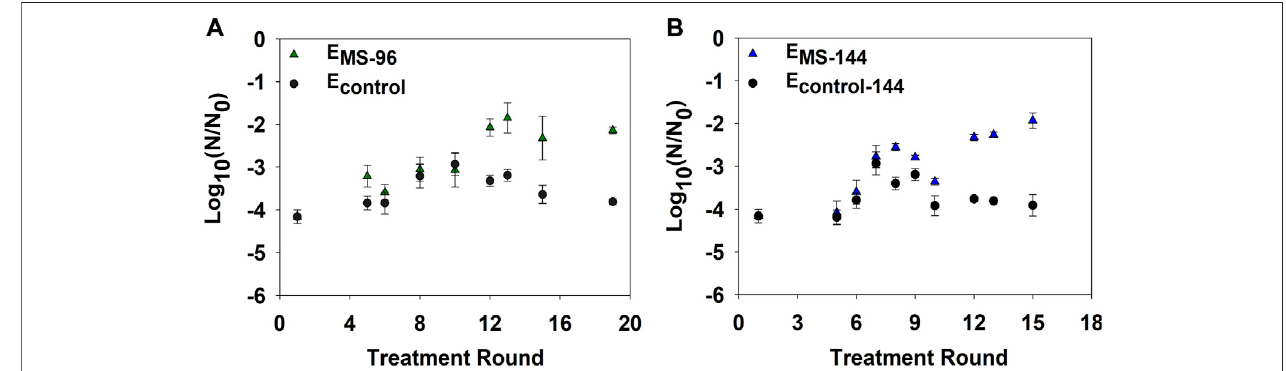
FIGURE5| E.coli log 10 inactivationaftermultipleroundsofgrowthanddisinfectionwith2.5 mg/LasCl 2 ofmonochloramine. (A) BacterialinactivationofE MS-96 due to repeated monochloramine disinfection every 96 h. (B) Bacterial inactivation E MS-144 due to repeated monochloramine disinfection every 144 h. E control-96 and E control- 144 were not repeatedly treated; subcultures ofeach were obtained and treated at select treatment rounds for comparison. Error bars represent one standard error ofat least triplicate samples. Initial cell concentration (N 0 ) ~10 8 CFU/ml; pH = 8.4; room temperature.